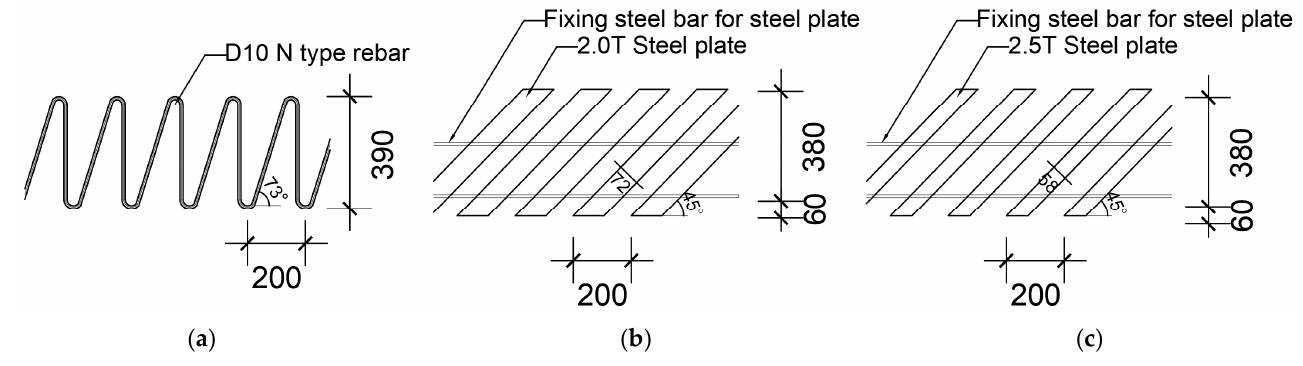
Figure 1. N-type rebar and steel plate shear reinforcement details [unit: mm]. ( a ) N-type rebar. ( b ) steel plate (2.0 T). ( c ) steel plate (2.5 T).